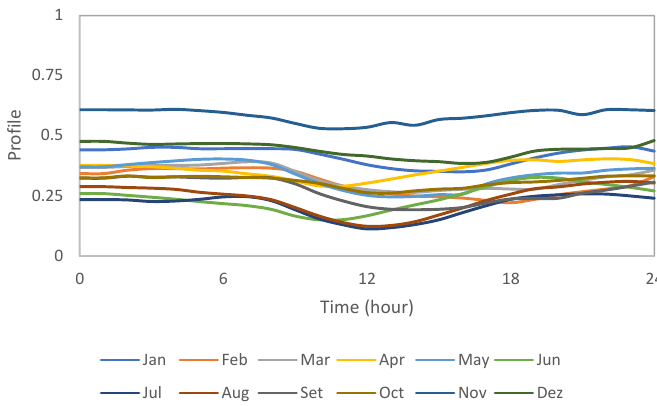
Figure A1. Average daily wind generation profiles, per month.